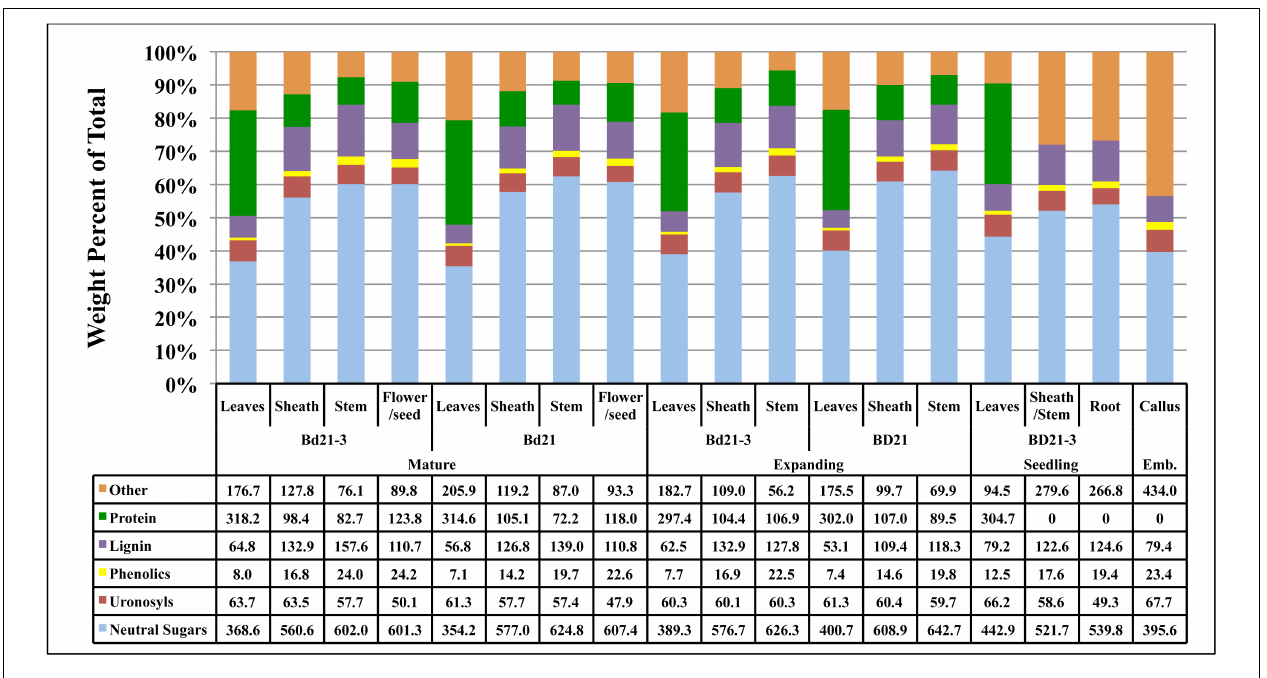
FIGURE 4 | Contribution of Brachypodium cell wall components to the total cell wall composition. The consolidation of cell wall weight percentages of neutral sugars (light blue), uronosyls (red), phenolics (yellow), lignin (purple), protein (green), and other (tan) to equal 100% is given for each